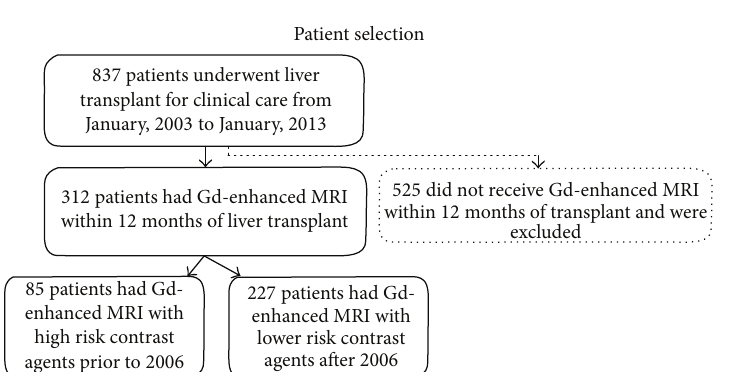
Figure 1: Flow chart of patient selection. Solid lines specify patients who were included in the study and dotted line specifies patients who were